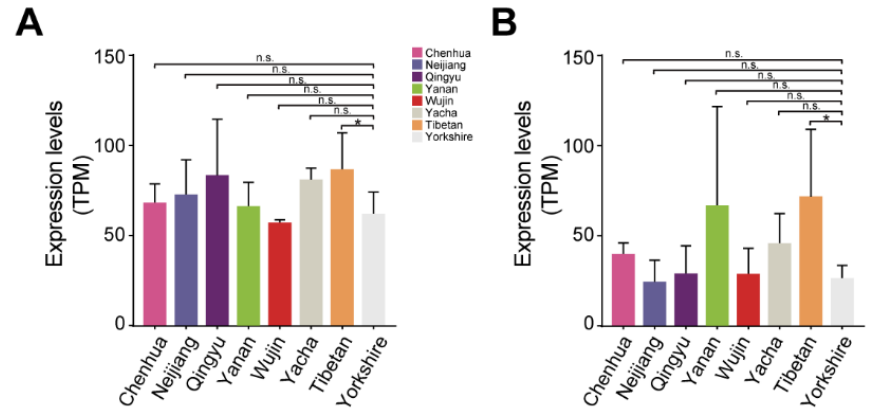
Figure 4. ( A ) Bar graph showing PLAAT3 expression in eight pig breeds. ( B ) Bar graph showing lnc PLAAT3 -AS expression in eight pig breeds. All results are presented as means ± SEM; n = 3.; * p < 0.05; n.s., no significant